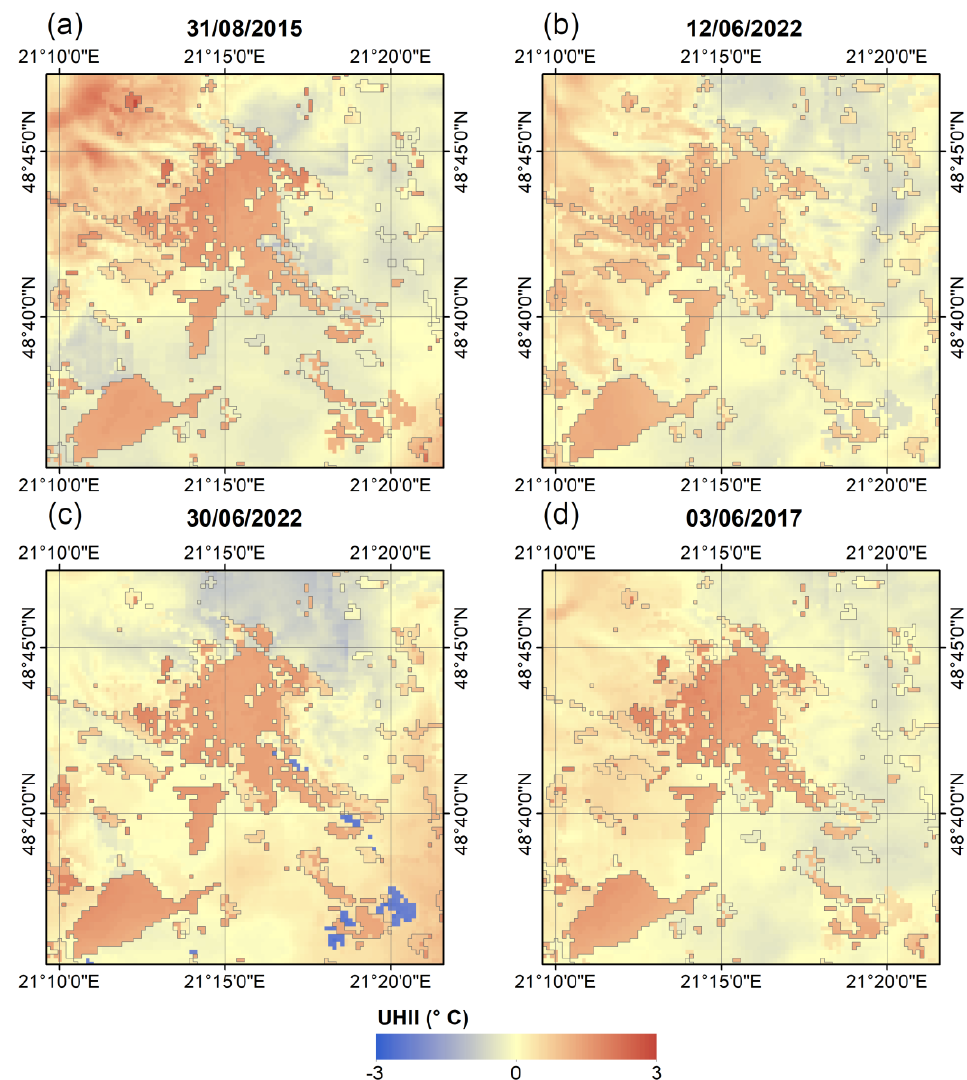
Figure 6. The average temperature at 2 m and average 10 m wind vectors from the third model domain (D3) with marked built-up areas during the ( a ) warm dynamic situation of 31 August 2015, ( b ) cold dynamic situation of 12 June 2022, ( c ) warm non-dynamic situation of 30 June 2022 and ( d ) cold non-dynamic situation of 3 June 2017.